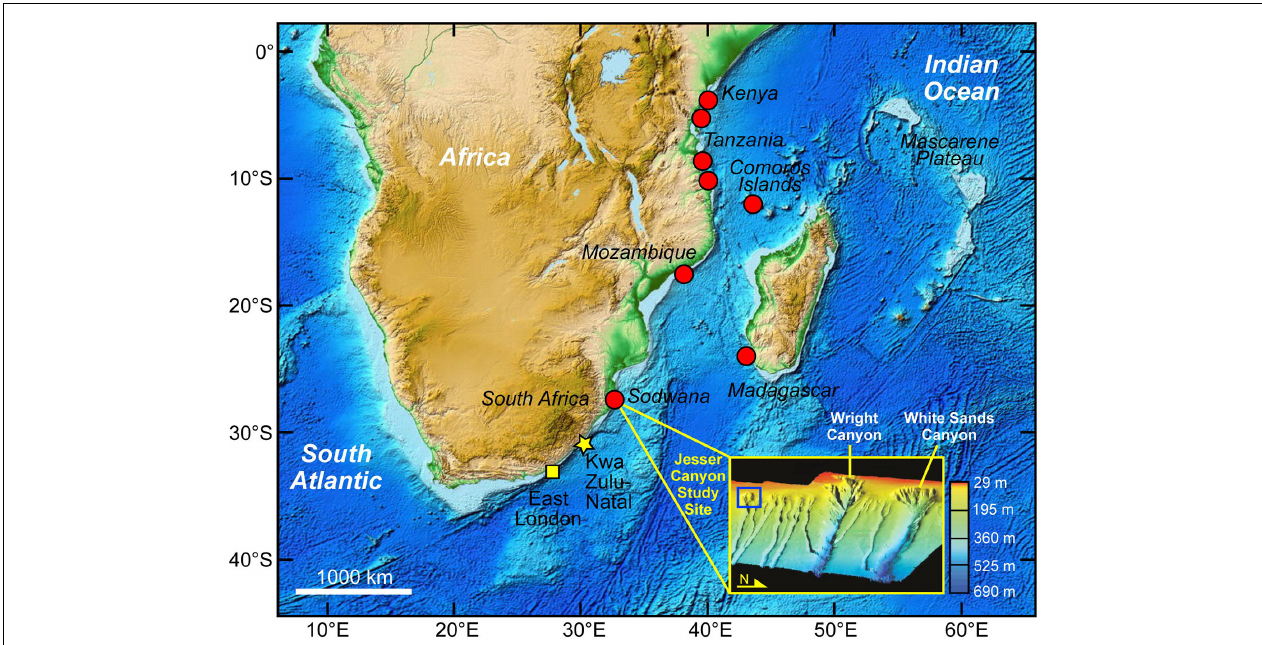
FIGURE 1 | Bathymetric map of the western Indian Ocean region showing the areas where living coelacanths, Latimeria chalumnae , have been observed by divers or underwater vehicles or caught by fishermen (red circles), the East London area where the species was first discovered in 1938 (yellow square), the most recent new area where divers observed a coelacanth (shown in Supplementary Figure 2 ) off the South Coast of KwaZulu-Natal 2019 (yellow star), and the inset shows a 3-D bathymetric depiction of the system of canyons that are located off the coast of Sodwana Bay in the northern area of iSimangaliso Wetland National Park in eastern South Africa. The present study was conducted June–July 2018 at the upper end of the southern branch of Jesser Canyon in the inset (blue square), which was redrawn from Ramsay and Miller (2006). The bathymetric map of the western Indian Ocean region was obtained from the NOAA National Centers for Environmental Information [NCEI; ETOPO1 Global Relief | NCEI (noaa.gov)], with color showing depth (dark blue showing deep and light blue shallow-depths). The areas where coelacanths have been found all have a narrow zone of continental shelf and steep slopes to deep